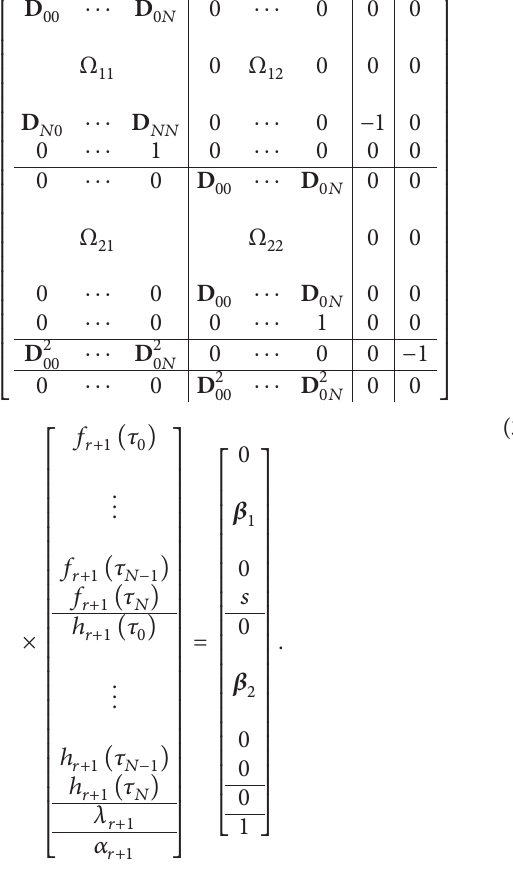
Table 1: Comparison between the SQLM values and the results of Bachok et al.